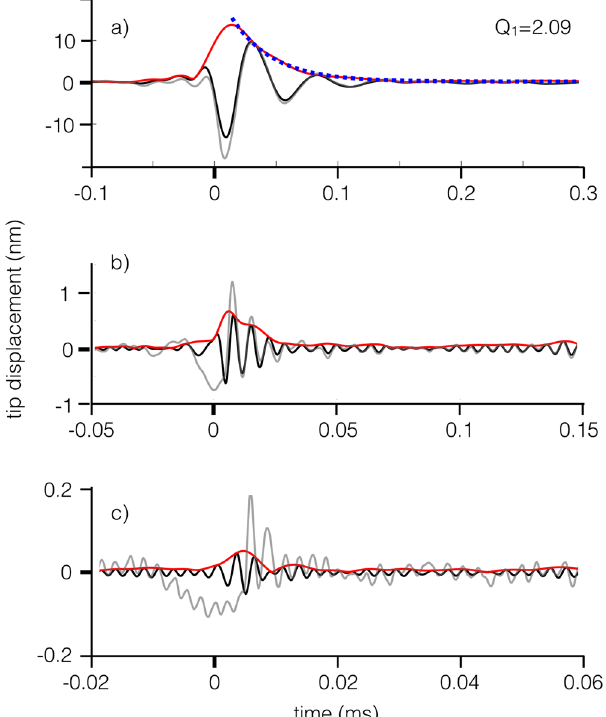
Figure 8. Time traces (black lines) of the first, ( a ) second, ( b ) third, ( c ) flexural eigenmodes retrieved by the inverse wavelet transform (iWT). The time-frequency intervals used to retrieve the time traces, expressed as [ t min , t max , f min , f max ] with time in ms and frequency in kHz, are as follows: ( a ) [ − 0.1, 0.3, 8, 50], ( b ) [ − 0.05, 0.15, 84, 256], ( c ) [ − 0.02, 0.06, 315, 445]. The red lines are the envelopes of the time traces. The light gray lines are the calculated time traces from the numerical simulation results. The dotted blue line in a) is an exponential fit to the decaying portion of the envelope, from which the Q 1 factor is calculated. Note the scaling of times and tip